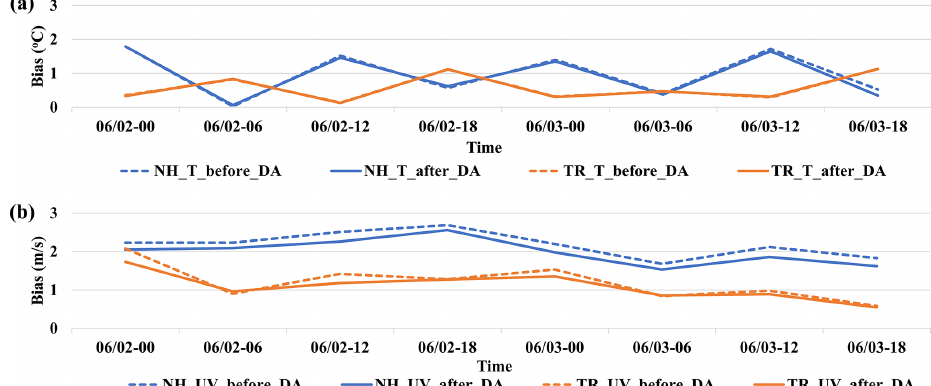
Figure 16. The same as in Fig. 13 but from experiment set 4 in Table 2.